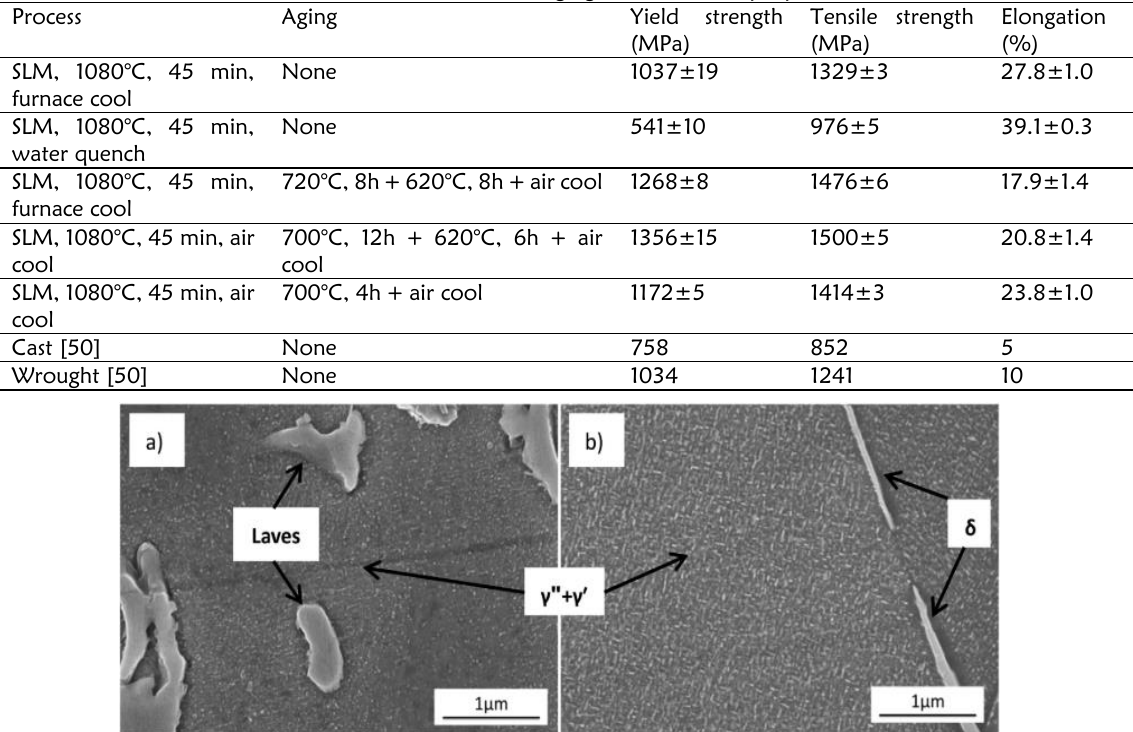
Figure 18: A comparison of constituents of the microstructure of (a) SLM IN718 and (b) wrought IN718. Here,  ’,  ’’,  and Laves are different precipitates in the IN718 microstructure